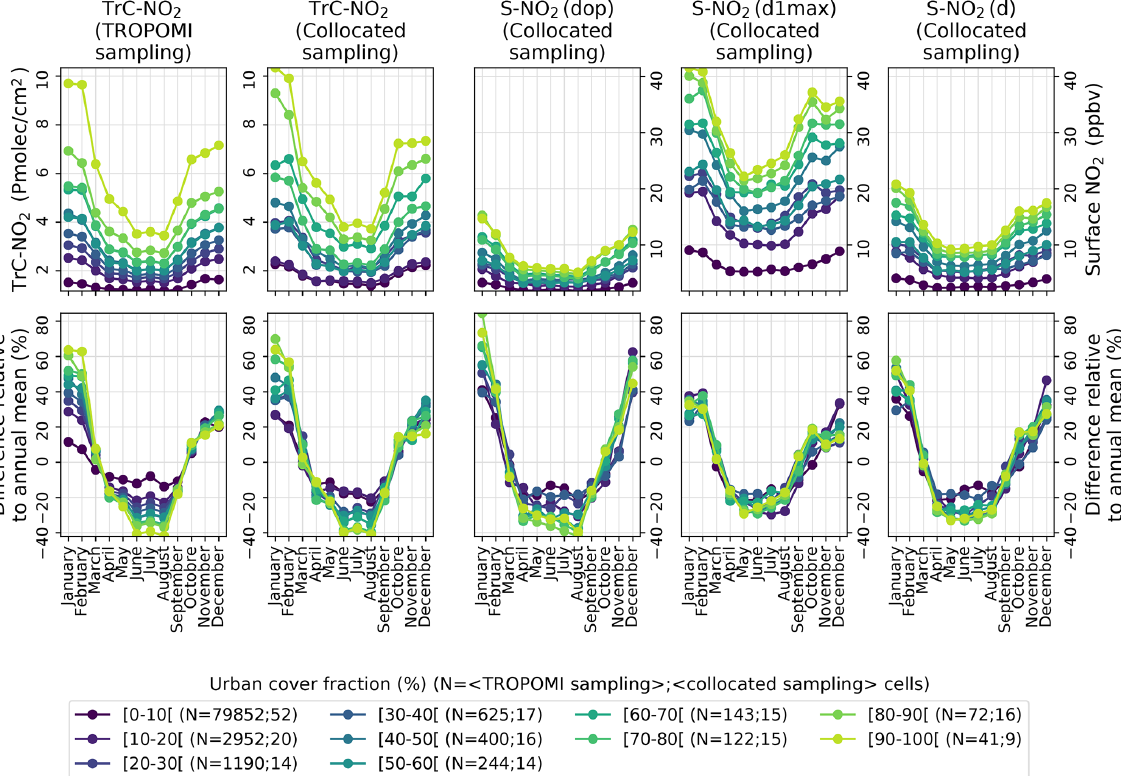
Figure F1. Mean monthly profiles (top panels) and differences relative to annual mean (bottom panels) for different levels of urban cover fraction, considering (from left to right panels) the TROPOMI TrC-NO 2 full dataset, TROPOMI TrC-NO 2 collocated with surface stations, surface NO 2 mixing ratios collocated with TROPOMI at daily TROPOMI overpass time (dop) and daily 1h maximum (d1max) and daily 24h mean (d) timescales. The collocation of TROPOMI-based and surface-based observations is here performed both spatially and temporally (on a daily basis); the corresponding numbers of cells (averaged over the different months of the year) are indicated in the legend. Urban cover fractions are here binned in bins of